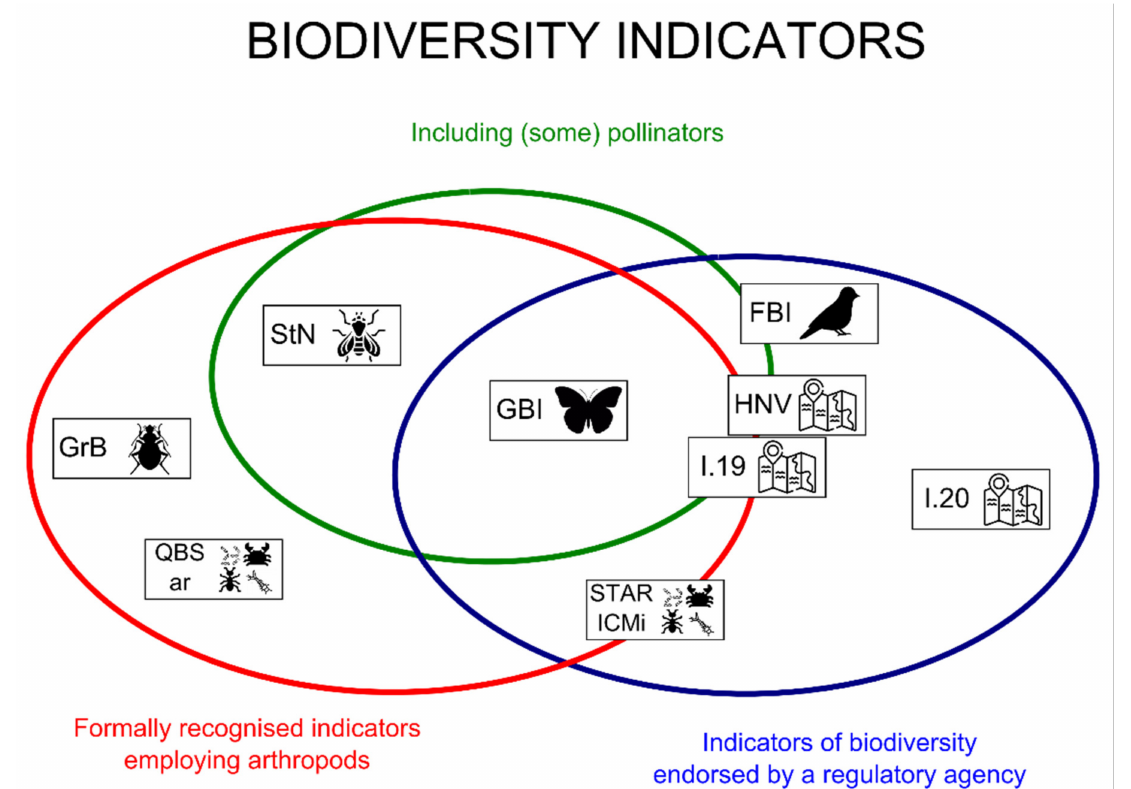
Figure 1. Relative position of selected indicators when considering their recognition and/or endorsement in current legislations (national and/or international). In the green circle fall those indicators including (at least some) groups of pollinators. This image has been designed using resources from Flaticon.com (authors of icons: Freepik, Eucalyp, Darius Dan, surang,